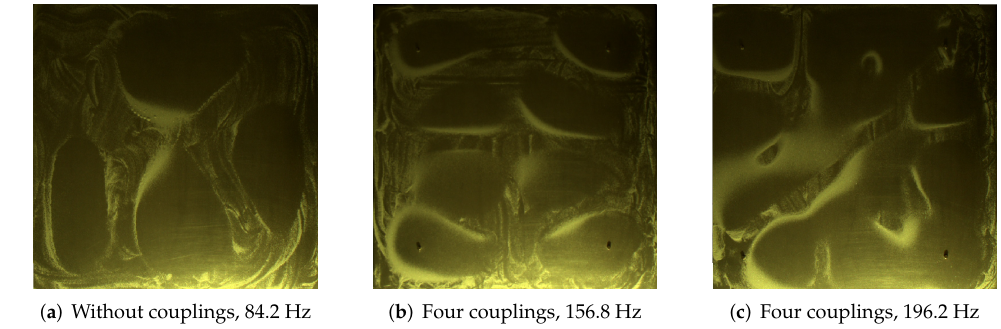
Figure 11. Samples of different mode